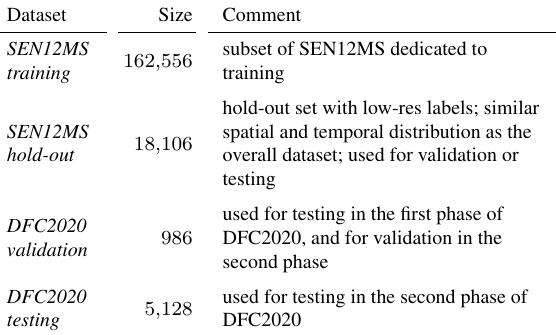
Table 2. The different sub-datasets that can be built from the SEN12MS and DFC2020